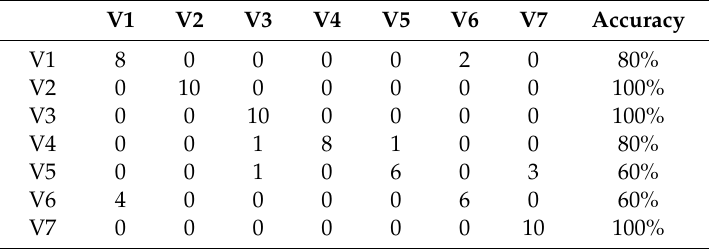
Table 7. Confusion matrix for sweet corn seed classification based on the SDA + NB